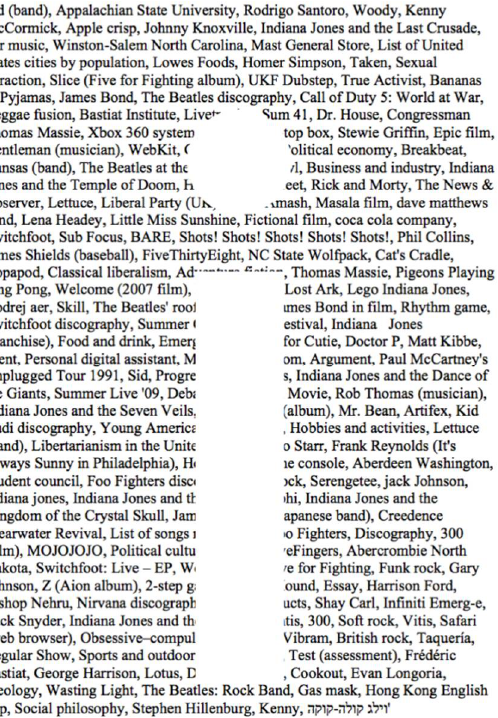
Figure 1. Student project, i .